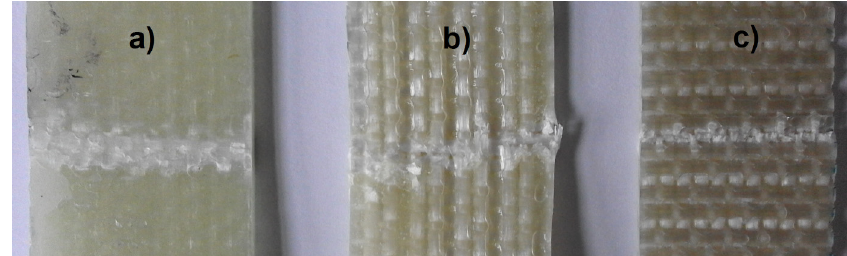
Figure 3. Failure after the bending tests visible on the upper surfaces of the exemplary samples: ( a ) Classic laminate; ( b ) 3D laminate W direction; ( c ) 3D laminate P direction.